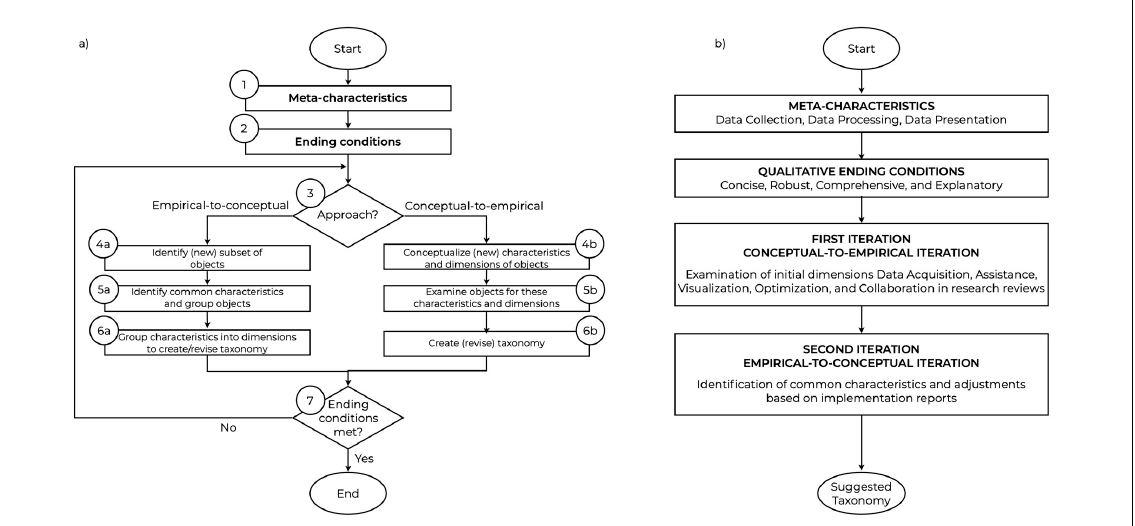
Figure 1. ( a ) Taxonomy development method according to Nickerson et al. [25] (p. 10), and ( b ) Applied procedure to derive an XR deployment purpose taxonomy .